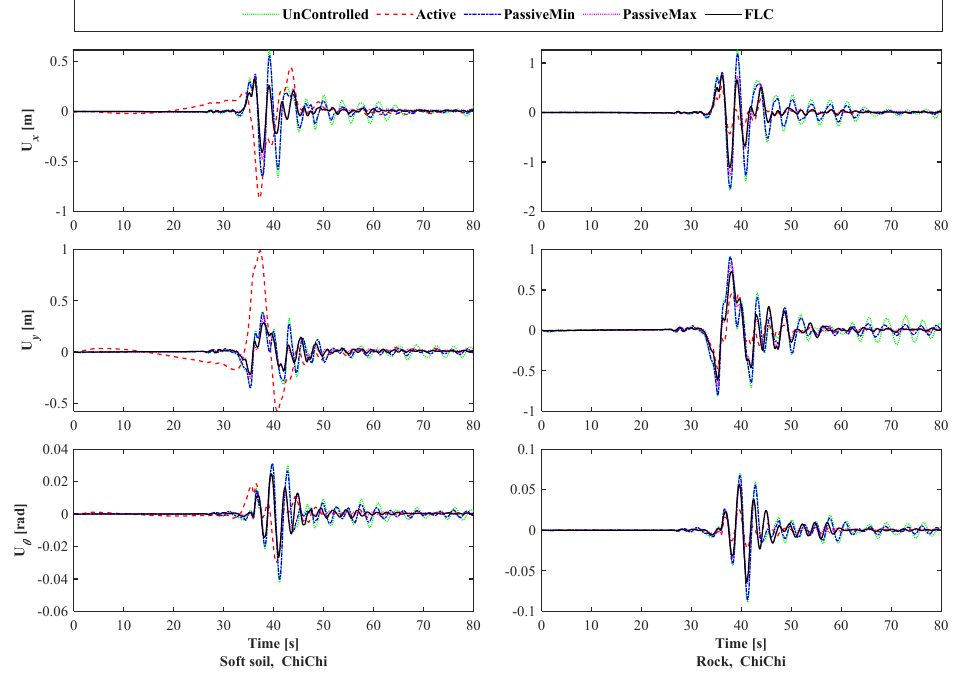
Figure 11. The time-history responses of the Case-I building considering SSI effects under the Chi-Chi earthquake.